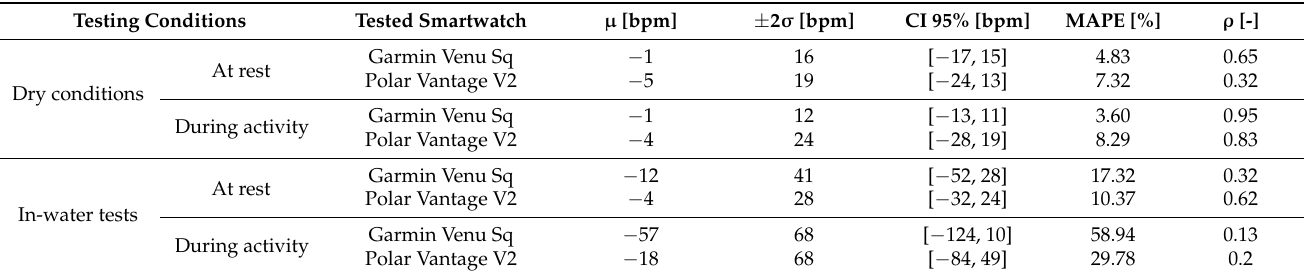
Table 4. Metrological performance of the tested smartwatches in terms of measurement accuracy (µ) and precision (±2 σ ), confidence interval at 95% (CI95%), mean absolute percentage error (MAPE), and Pearson’s correlation coefficient ( ρ )—dry vs. in-water conditions, separating tests at rest and during activities.